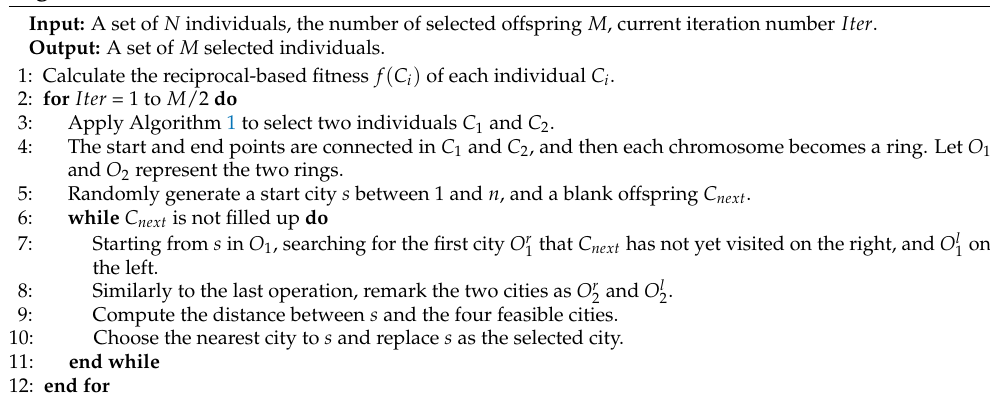
Algorithm 3 Selective bidirectional heuristic crossover.